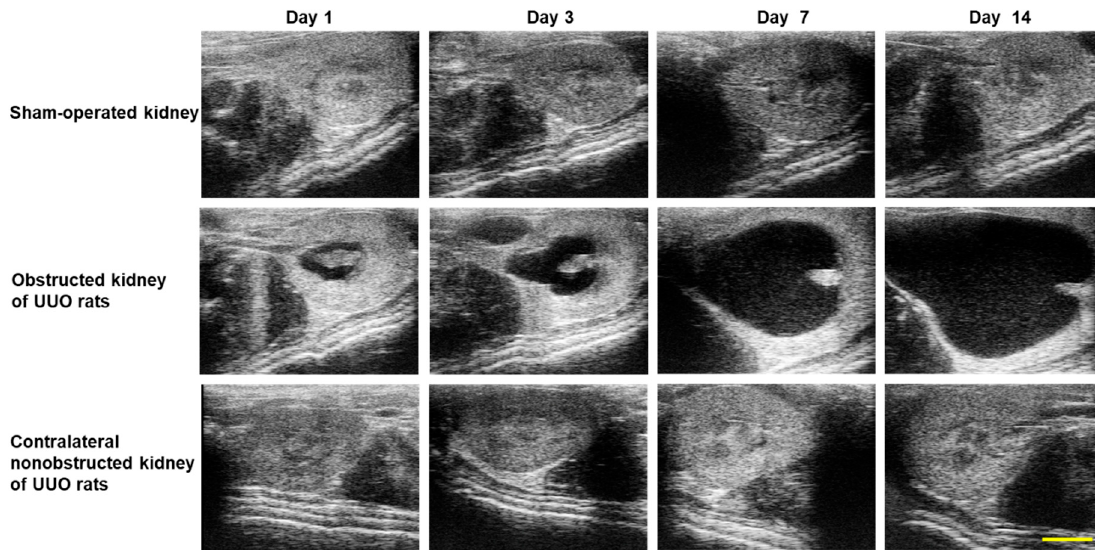
Figure 1. Echographic images of kidneys from sham-operated rats and rats with UUO. Representative echographic images of kidneys from sham-operated rats and rats with UUO using the Vevo 1100 Imaging System. Scale bar: 5 mm.